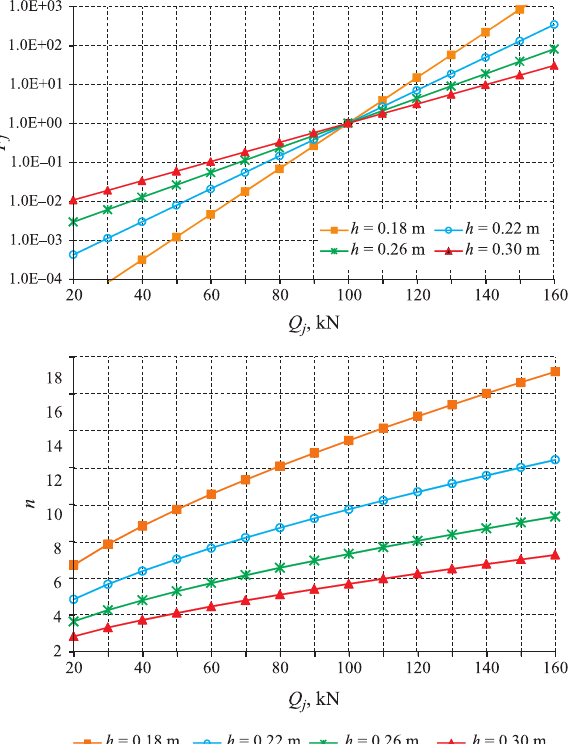
Fig. 2. Equivalent axle load factors F j and exponent n in relation obtained from Portland Cement Association criterion as a function of actual axle load Q j and thickness of concrete slab h (for R b = 5.5 × 10 3 kN/m 2 , E = 35 × 10 6 kN/m 2 ; k = 100 × 10 3 kN/m 3 , Q s = 100